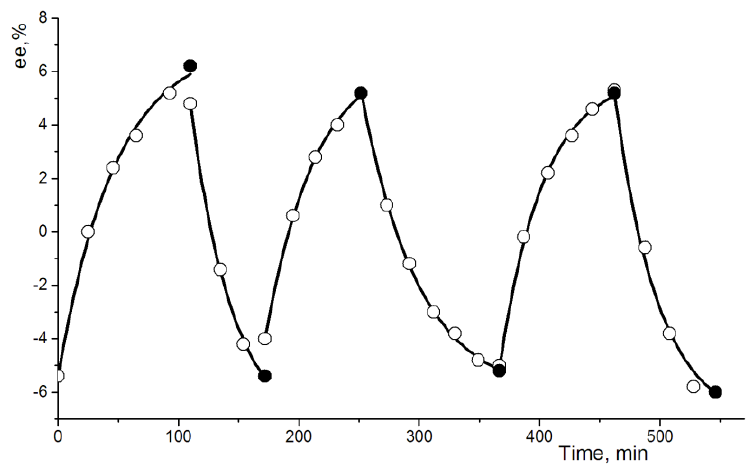
Figure 12. Mother liquor enantiomeric excess vs time of preferential crystallization of slightly enantiomerically enriched diol 1 . Closed circles represent the values of ee , on reaching which the process was